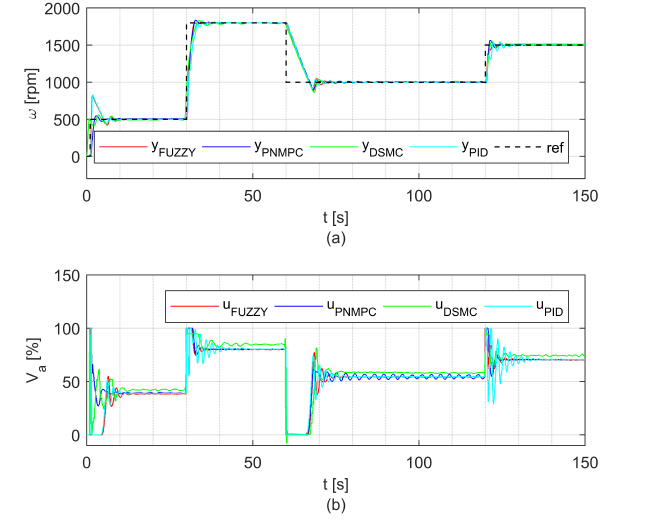
Figure 14. Output signal of the DC motor system in the test with application of step signal: ( a ) speed and ( b ) armature